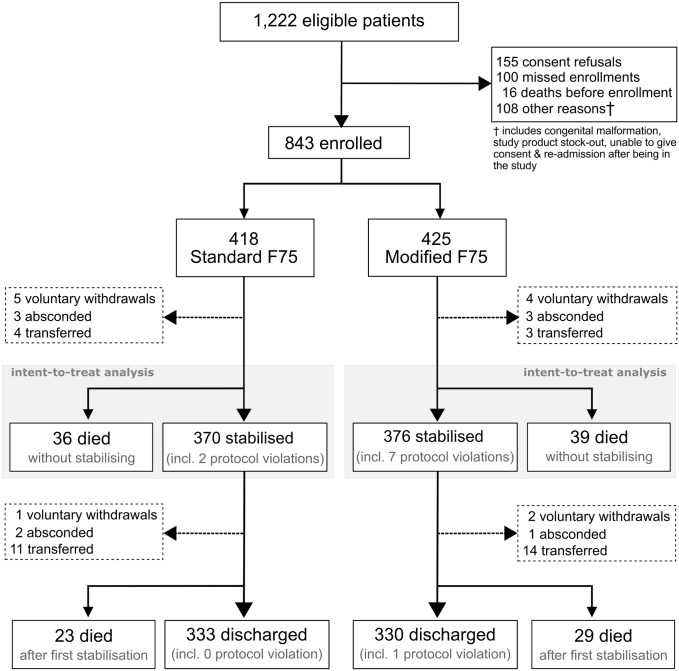
Numbers of children who were screened, assigned a trial group, and included in the primary analysis.Children aged 6 months to 13 years who were admitted for complicated SAM were screened for eligibility in the participating hospitals. They were enrolled after informed consent was obtained. SAM, severe acute malnutrition.